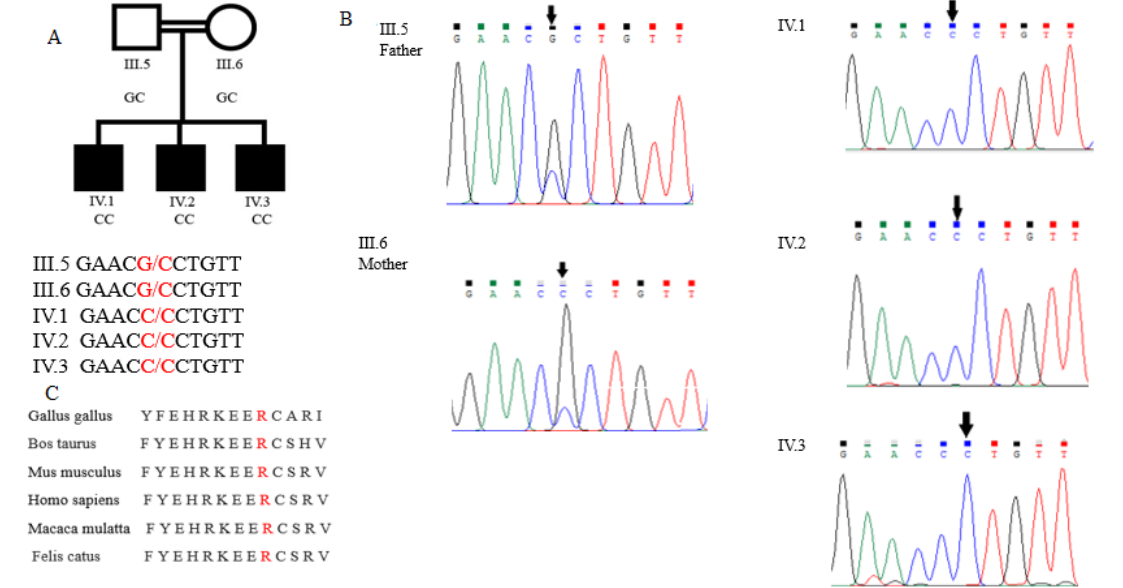
Figure 2. Chromatogram and Clustal Omega alignment of PAPSS2. ( A ) Three individuals (III-5, III-6 and IV-2) were selected for whole exome sequencing. According to the mode of inheritance, individuals with normal height (III-5 and IIIV.6) carried heterozygous alleles (G/C), while affected individuals (IV-2) carried homozygous mutant alleles (C/C). Mutation in five family members was confirmed by Sanger sequencing. ( B ) Chromatogram for PAPSS2-selected region showing c.1037G > C transition. ( C ) Multiple sequence alignment of PAPSS2 from six different organ- isms performed with Clustal Omega showing R346P (shown in bold) conservation in diverse vertebral species.